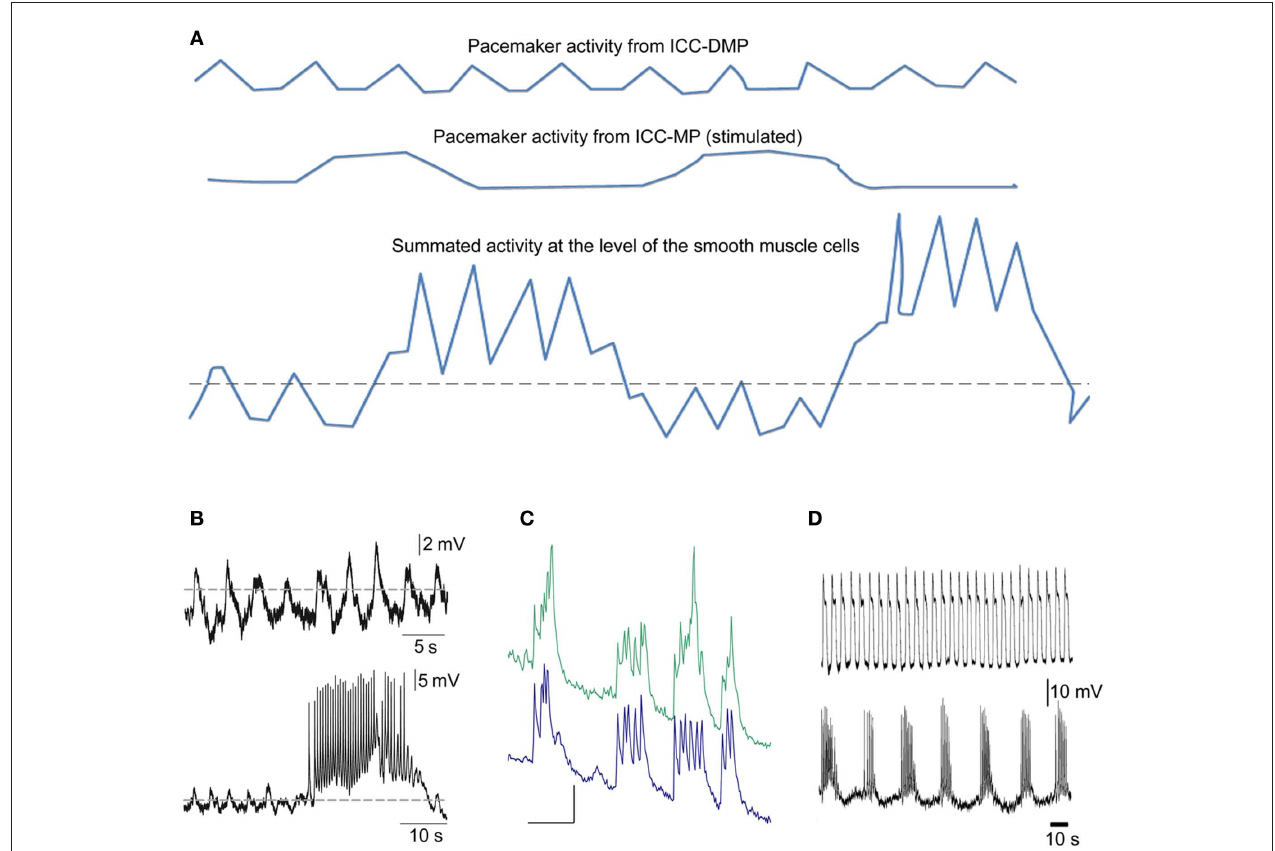
FIgurE 5 | Schematic drawing of the proposed electrophysiological basis of the rhythmic propulsive motor complexes. (A) Smooth muscle cells of the colon may only receive slow wave activity propagated from ICC–SMP (top line). This may be associated with small amplitude contractions if the slow waves barely pass threshold (dotted line) for generation of action potentials dependent on activation of L-type calcium channels. When the rhythmic transient depolarizations hypothesized to come from ICC–MP under stimulated conditions (middle line) are also received by the smooth muscle cells, de cells will obviously rhythmically depolarize and the slow waves will be pushed well above the threshold and hence action potentials and hence